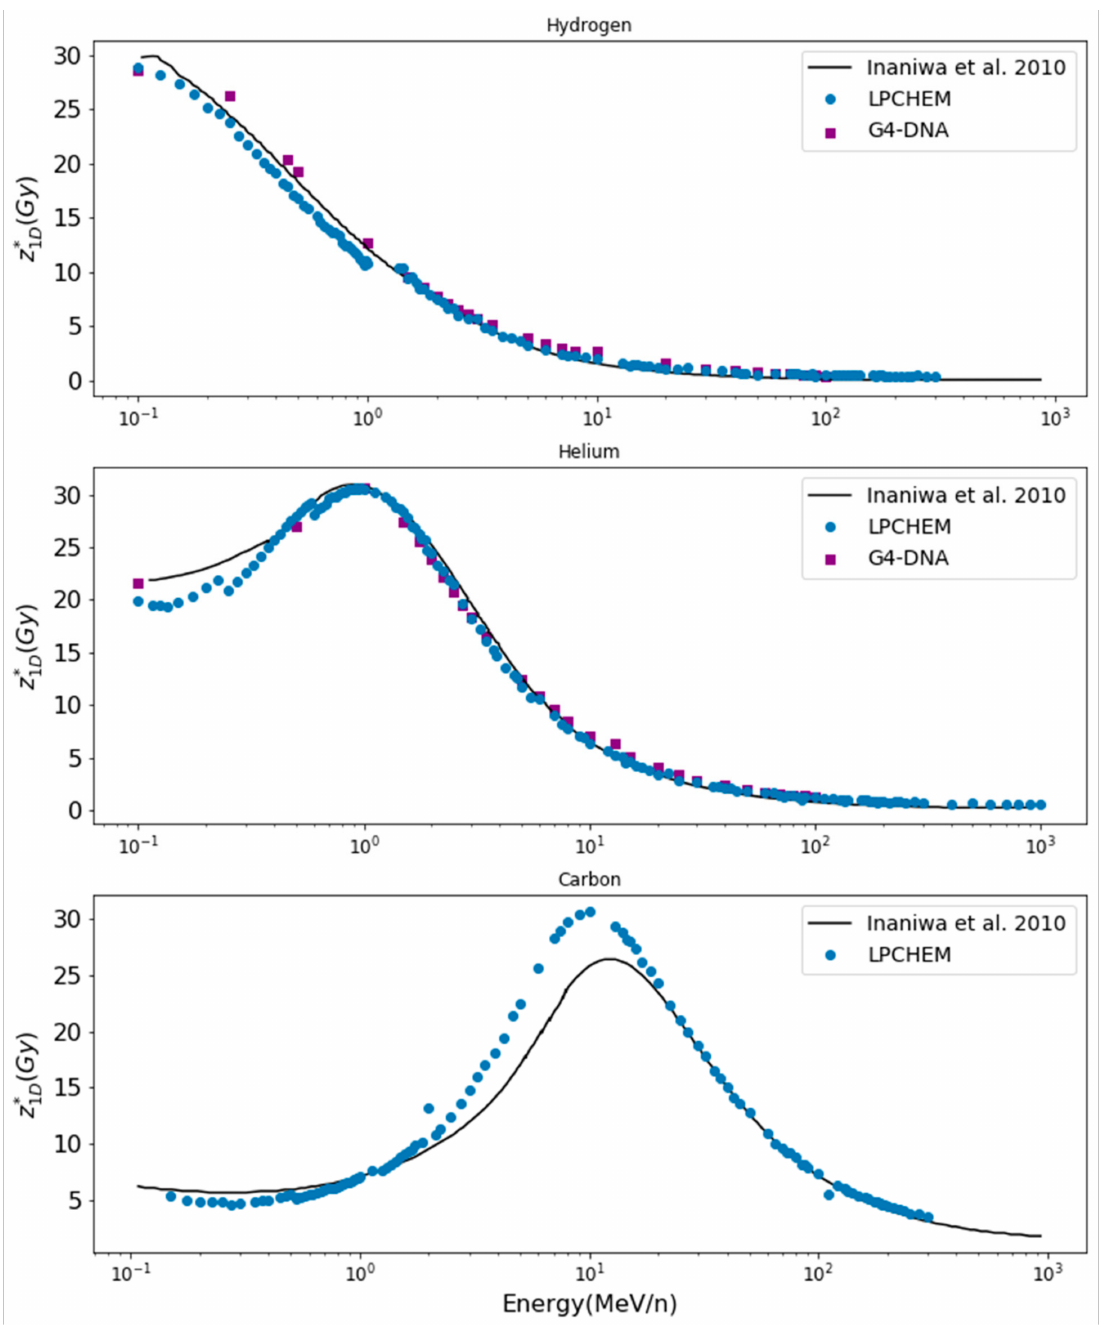
Figure 2. z ∗ values as a function of the kinetic energy of hydrogen, helium and carbon ions for HSG 1 D cells. Values from Inaniwa et al. were obtained from the track structure of the Kiefer–Chatterjee model